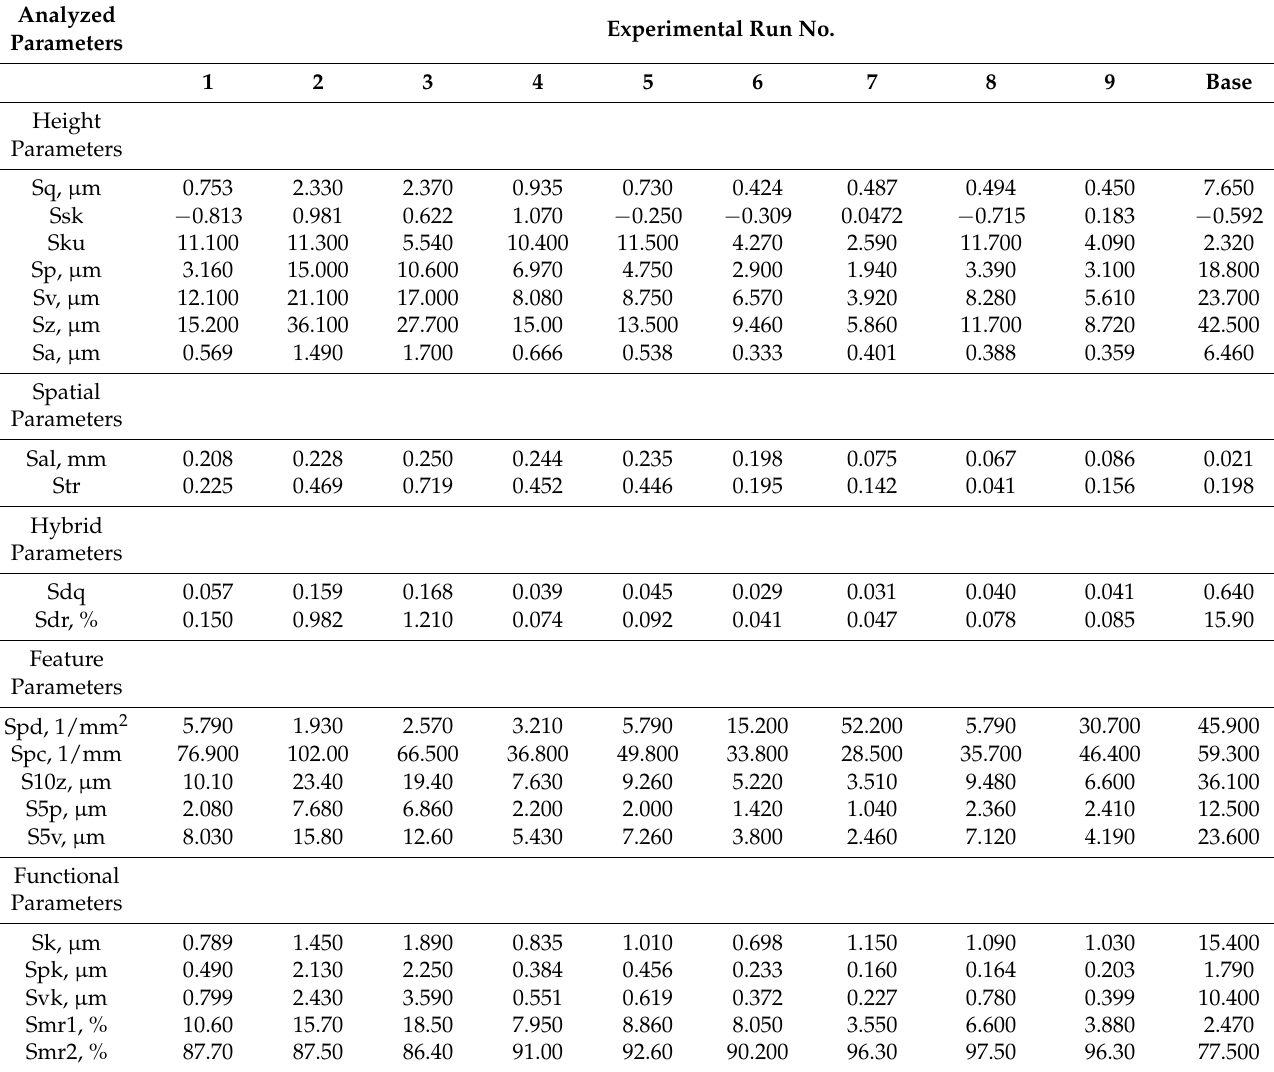
Table 7. Results of surface roughness of the EN AW-2024-T3 aluminum alloy burnished using a diamond